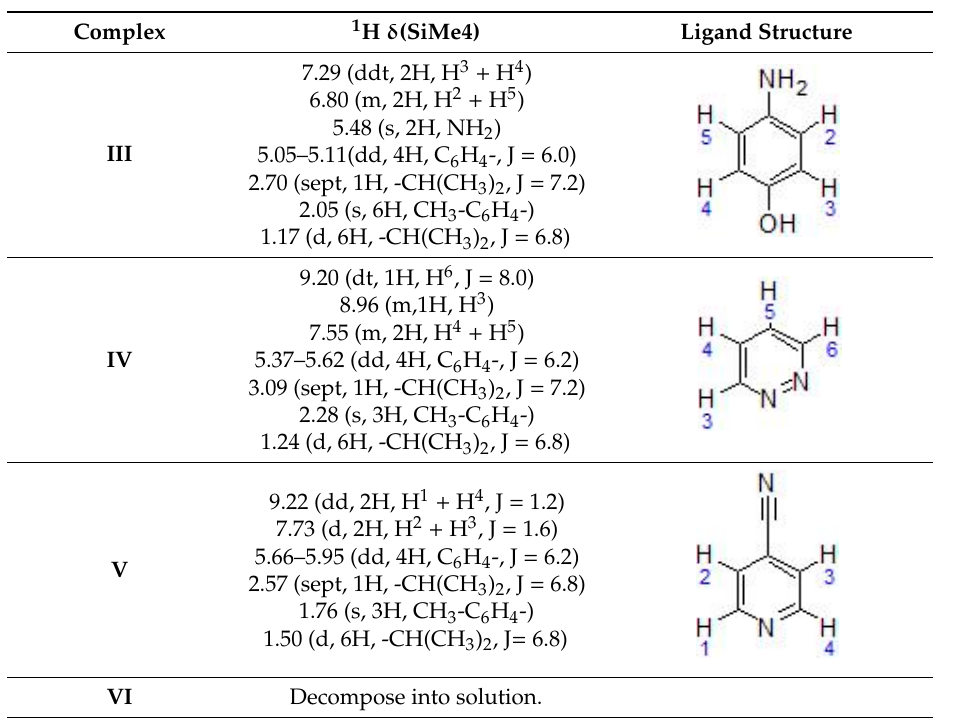
Table 3. NMR-1H data of the complexes III–VI. (J = Hz).